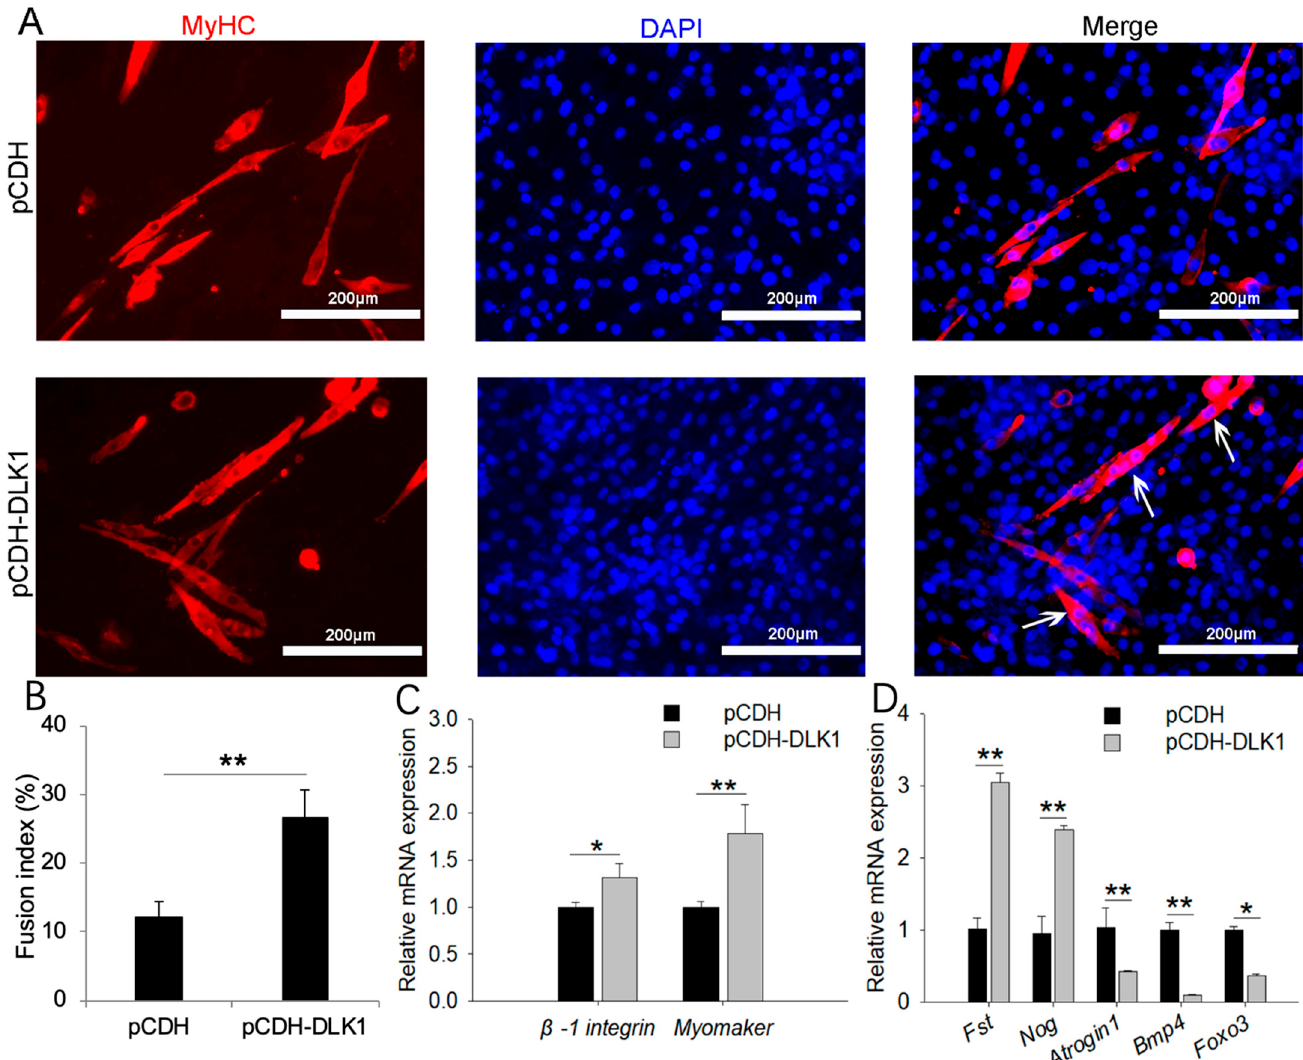
Figure 5. DLK1 stimulated myoblast fusion and muscle hypertrophy but suppressed muscle degra- dation. ( A ) Myoblast fusion analysis by immunofluorescence staining for MyHC after four days of differentiation, and the white arrows represent the multinucleated myotubes; white scale bar = 200 µm; ( B ) the fusion index was measured by dividing the number of nuclei found within the myotubes by the total number of nuclei; ( C ) the mRNA expression of fusion marker genes was quantified by a quantitative real-time polymerase chain reaction (qRT-PCR); ( D ) the mRNA expression of muscle hypertrophy genes ( Fst and Nog ) and muscle degradation markers ( Atrogin1 , Bmp4 , and Foxo3 ) was quantified by qRT-PCR. The data represent the mean ± SD of three independent experiments. * p < 0.05, ** p < 0.01.